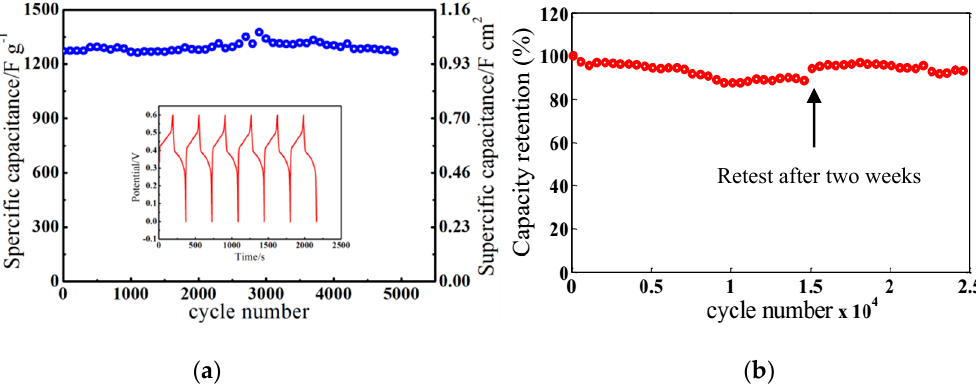
Figure 5. ( a ) Cycling performance of the MnO 2 –MWNT–Ni foam electrode. ( b ) Capacity retention property of the MnO 2 –MWNT–Ni foam electrode.